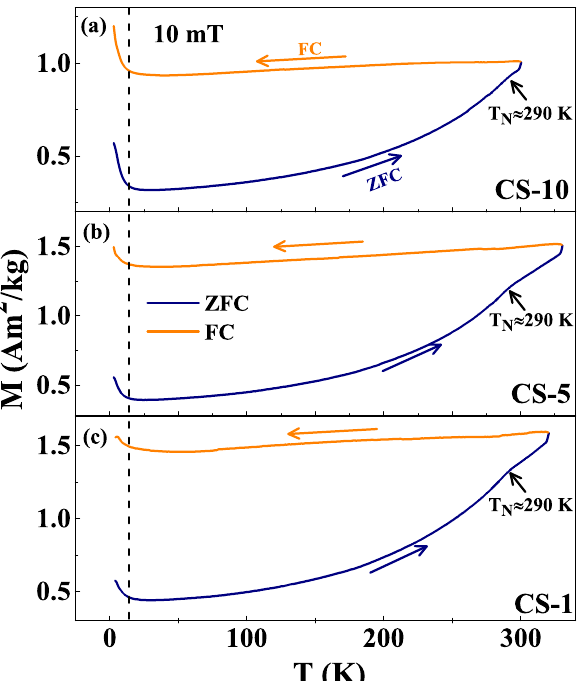
Figure 4. Thermal dependence of the ZFC and FC magnetization of samples ( a ) CS-10, ( b ) CS-5 and ( c ) CS-1, at 10 mT. Anomalies evident near 290 K correspond to the Néel temperature ( T N ) of CoO. In the low-temperature region, a Cuire tail-like behavior is observed for all the